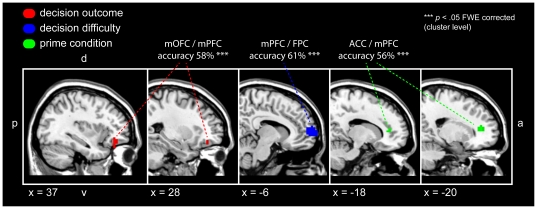
Decoding decision aspects and prime conditions.A moving searchlight decoder with a radius of 3 voxels was used to predict decision aspects from local brain activation patterns (p<0.05 FWE corrected cluster threshold for all). Clusters in anterior cingulate cortex (ACC)/medial prefrontal cortex (mPFC) (peak accuracy 58%) and visual cortex (peak accuracy 58%, not displayed) encoded the prime condition (Apple vs. neutral cup) for temporal discounting (green). A region in left mPFC/FPC encoded decision difficulty (‘easy’ vs. ‘hard’; peak accuracy 61%; blue). There was no difference between the Apple condition and the neutral cup condition (p>0.1). The decision outcome (‘now’ vs. ‘later’) could be decoded from right mOFC (peak accuracy 58%; red) for all TD decisions. More detailed prime-specific analyses could not be performed because seven subjects were too unbalanced in their binary decision outcomes (see main text). Error bars = SEM.